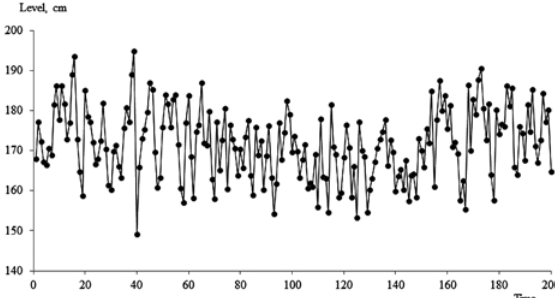
fig. 7. modeling of the trajectory of the level fluctuations in lake naroch.